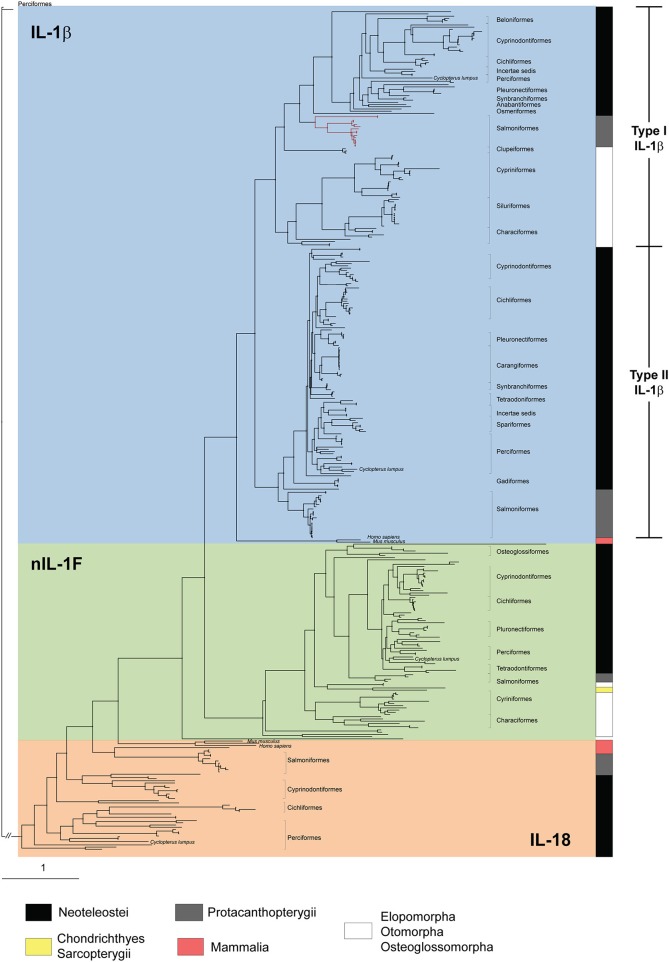
Phylogenetic tree of IL-1β type I and type II, IL-18, and nIL-1F. All full-length fish IL-1 ligands, and the human and mouse IL-1β and IL-18 sequences, are included. The phylogenetic tree was made using maximum likelihood as described in material and methods. Phylogenetic distance is indicated by branch length. Bar indicates distance of 1 substitution per amino acid site. Salmonid IL-1 β3 sequences within the type I group are shown with red line. A detailed phylogenetic tree which include sequence information (species and accession numbers) and bootstrap values (>80%) of 100,000 iterations is shown in Supplemental Figure 5 and listed in Supplemental Table 4.